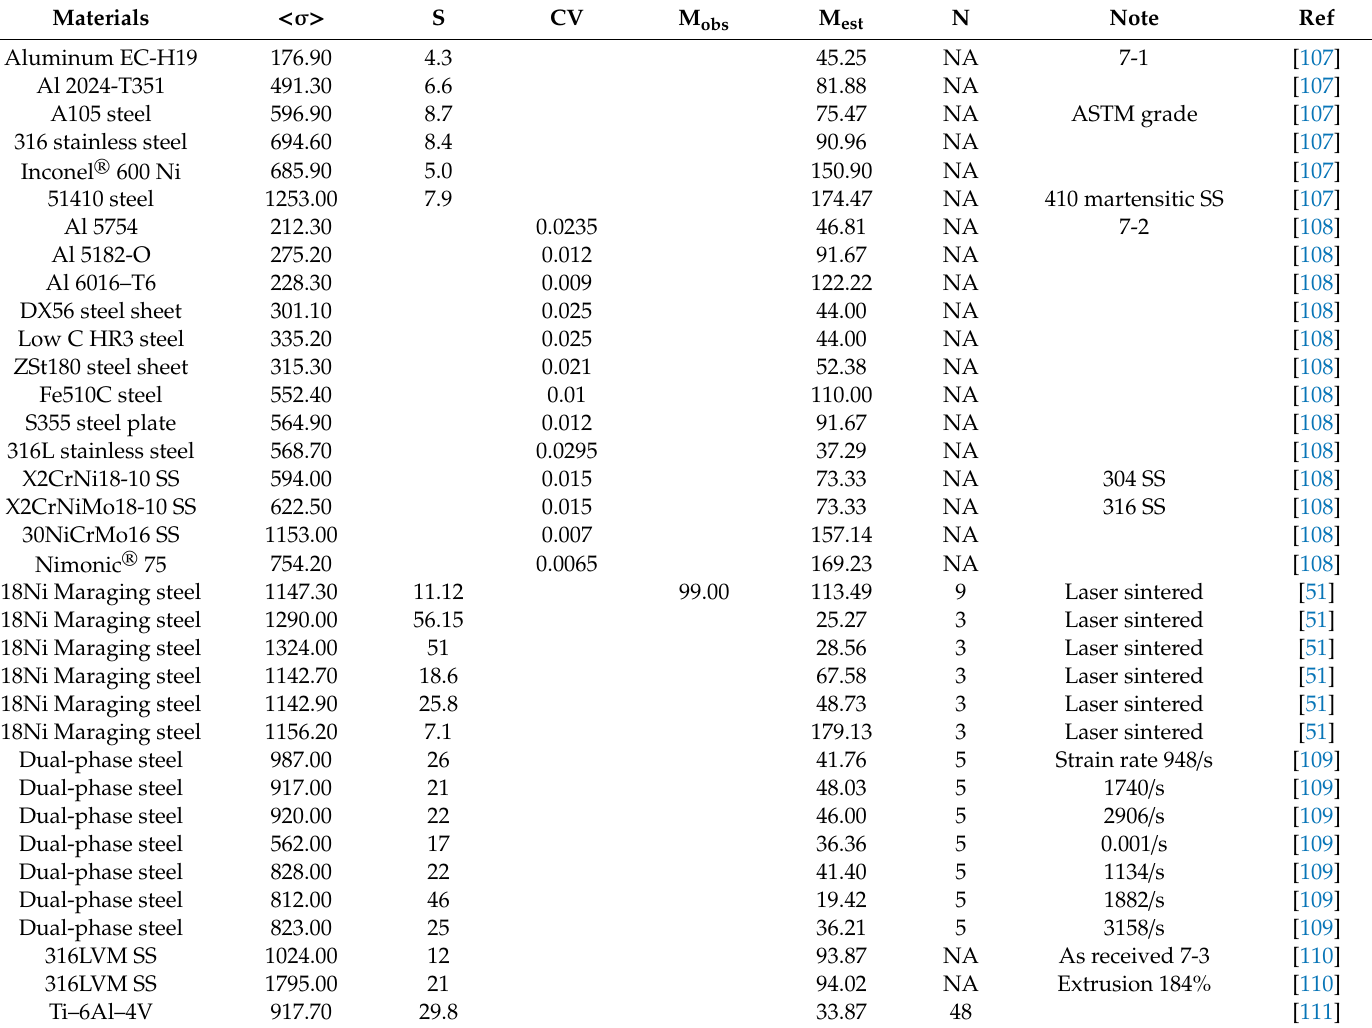
Table 7. Listing of data for estimated m values using S or coe ffi cient of variation (CV) and for observed